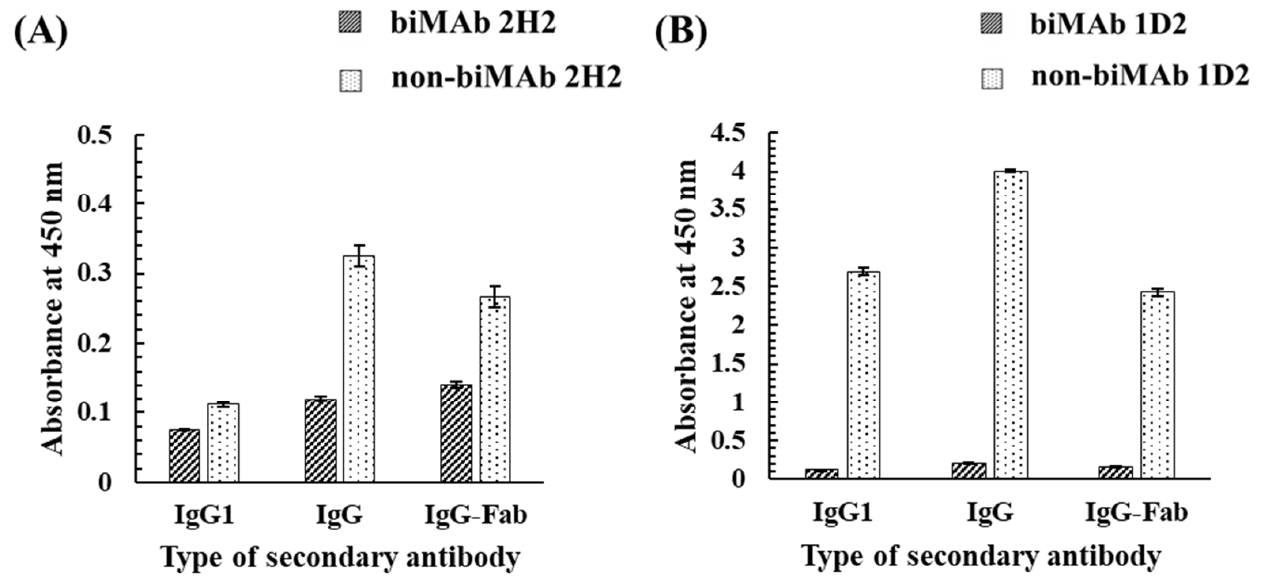
Figure 8. The effect of bioimprinting on the binding ability of ( A ) MAb 2H2 and ( B ) MAb 1D2 to GC and HT, evaluated by iELISA. The GC-HSA and HT-HSA conjugates (2 µ g/mL) were immobilized to the plate, and biMAb 2H2 or biMAb 1D2 (300 µ g/mL) was applied after blocking; IgG1, IgG, and IgG-Fab represent anti-mouse IgG1 goat antibody (HRP), anti-mouse IgG goat antibody (HRP), and goat F(ab) anti-mouse IgG H&L (HRP), respectively, were used as a secondary antibody.